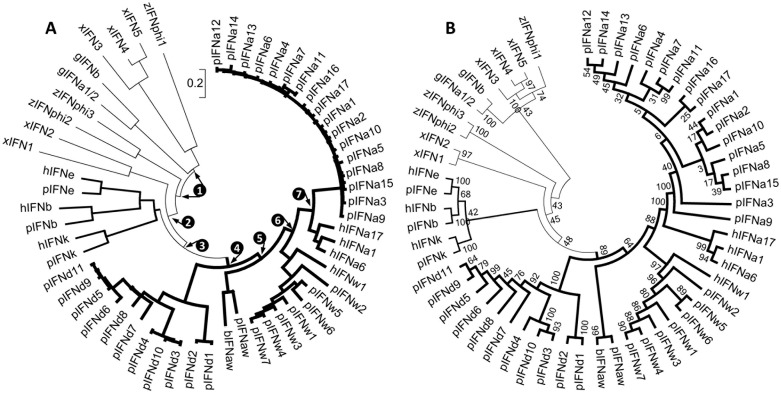
Phylogenic analysis of porcine type I IFNs in cohort with orthologs from other species.Evolutionary analyses were conducted in MEGA5 [27] to show relative branch length (A) and tree topology with bootstrap values (B). Internal nodes corresponding to the hypothetical common ancestors of mammalian (primarily porcine) type I IFNs evolved from lower vertebrate IFN-like molecules are illustrated using circled numbers around the center. The bootstrap consensus tree inferred from 1000 replicates is taken to represent the evolutionary history of the taxa analyzed. The evolutionary history was inferred using the Neighbor-Joining method. Bootstrap values are indicated along each branch. The evolutionary distances were computed using the Poisson correction method and are in the units of the number of amino acid substitutions per site. Tree branch and taxa legend: Tree branches of solid lines with increased width illustrate the evolution of type I IFNs from IFN ancestors in zebrafish (z), Xenopus (x) and Gallus (g) to diverse mammalian subtypes exemplified with porcine (p) type I IFNs and some typical orthologs in human (h) or bovine (b). IFN taxa used, IFNa, IFNaw, IFNb, IFNd, IFNe, IFNk and IFNw correspond to IFN-α (IFNA), IFN-αω (IFNAW), IFN-β (IFNB), IFN-δ (IFND), IFN-ε (IFNE), IFN-κ (IFNK) and IFN-ω(IFNW), respectively, in classic nomenclature for IFN protein (gene) precursors.